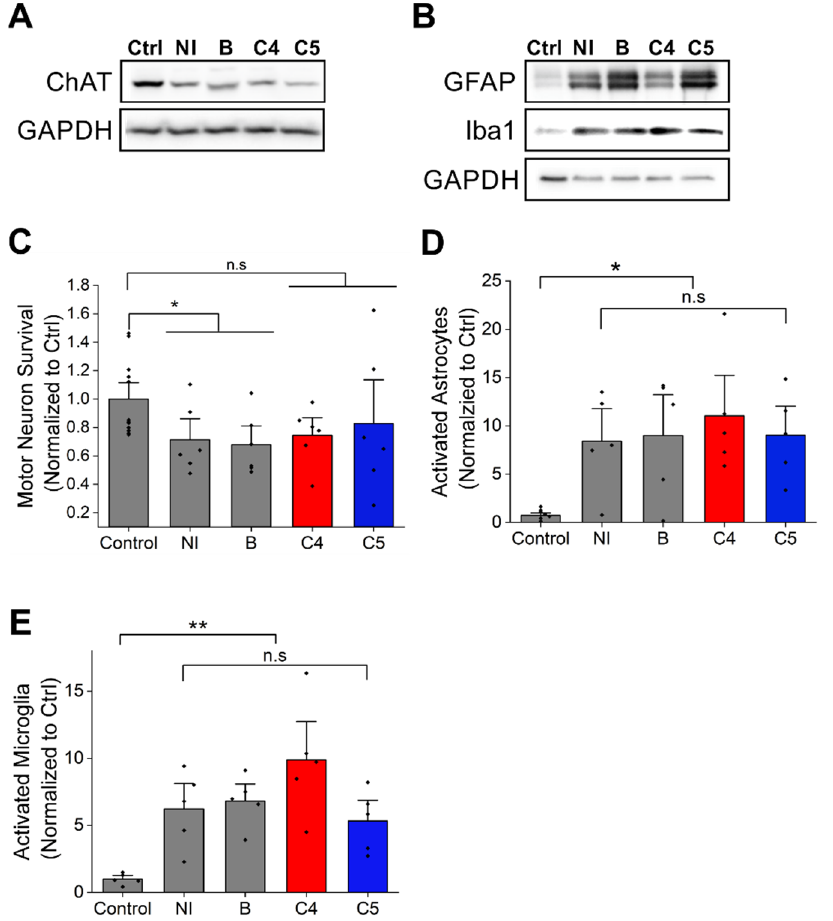
Figure 4. C4 and C5 treatment had no effect on motor neuron survival or the neuroinflammatory response in SOD1 G93A mice spinal cords. ( A ) Motor neurons survival was evaluated by immunoblot of lysates from spinal cords of non-transgenic and SOD1 G93A mice with anti-ChAT antibody. ( B ) Quantification of ChAT level intensity in non-transgenic mice (control) and C4- and C5-treated and untreated SOD1 G93A mice. ( C – E ) Neuroinflammatory response was evaluated by immunoblot of lysates from spinal cords of non-transgenic and SOD1 G93A mice with anti-GFAP and anti-Iba1 antibodies ( C ). ( D ) Quantification of activated astrocytes (GFAP antibody, D) and activated microglia (Iba1 antibody, ( E )) in non-transgenic and SOD1 G93A mice untreated or treated with C4 or C5. Ctrl- non-transgenic mouse; NI- SOD1 G93A noninjected; B- SOD1 G93A injected with acetate buffer. Quan- tification analysis was performed with Student’s t -test. Bars represent mean ± SEM. Data indicate one representative experiment out of 3–5 independent experiments. n.s, nonsignificant; * p < 0.05; ** p <